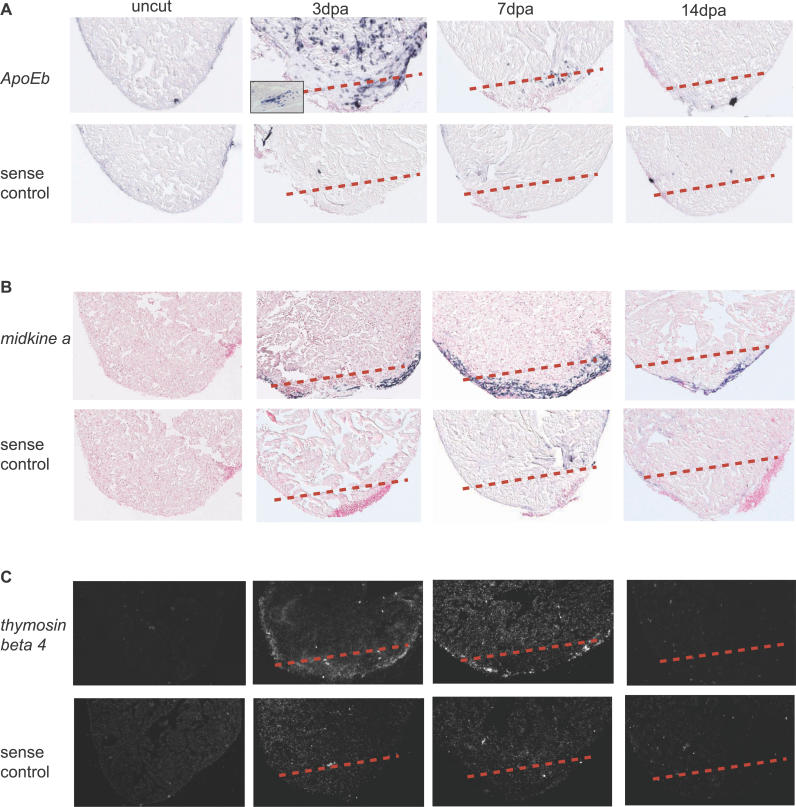
apoEb, midkine a, and
thymosin β
4 Are Expressed around the Wound Site during Zebrafish Heart Regeneration
Spatial expression patterns of
apoEb,
midkine a, and
thymosin β
4 in sham-operated hearts (uncut) and regenerating hearts at 3, 7, and 14 dpa were determined by in situ hybridization.
(A) The expression pattern of
apoEb was determined using a DIG-labeled antisense probe.
apoEb was highly expressed at 3 dpa; its punctate expression suggests that it is expressed by infiltrating macrophages (see the higher magnification image in the inset).
(B) Expression level of
midkine a was upregulated from 3 dpa, reaches a peak at 7 dpa and lasts until 14 dpa. It appears to be expressed around the wound site in the compact layer of myocardium and the epicardium.
(C) The expression pattern of
thymosin β
4 was determined using a radioactive antisense probe.
thymosin β
4 appears to be expressed around the wound and surrounding compact myocardium. Sense probes for each gene were used as negative controls. A dashed line marks the amputation plane.